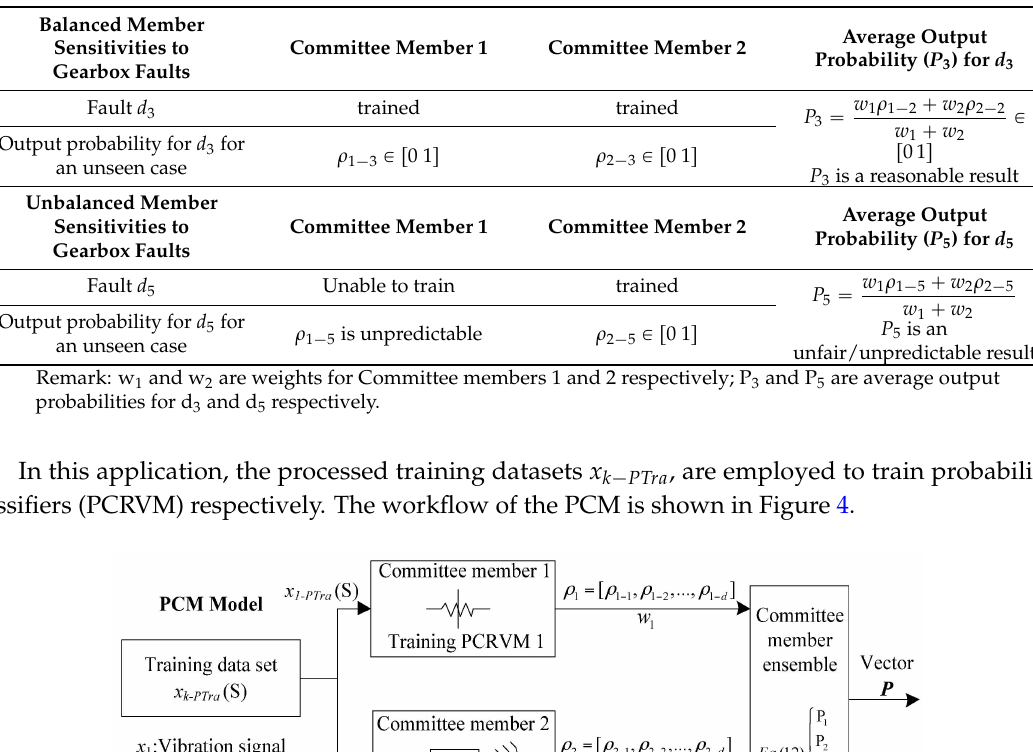
Table 2. Issue of weighted averaging method for balanced and unbalanced committee member sensitivities to gearbox faults.